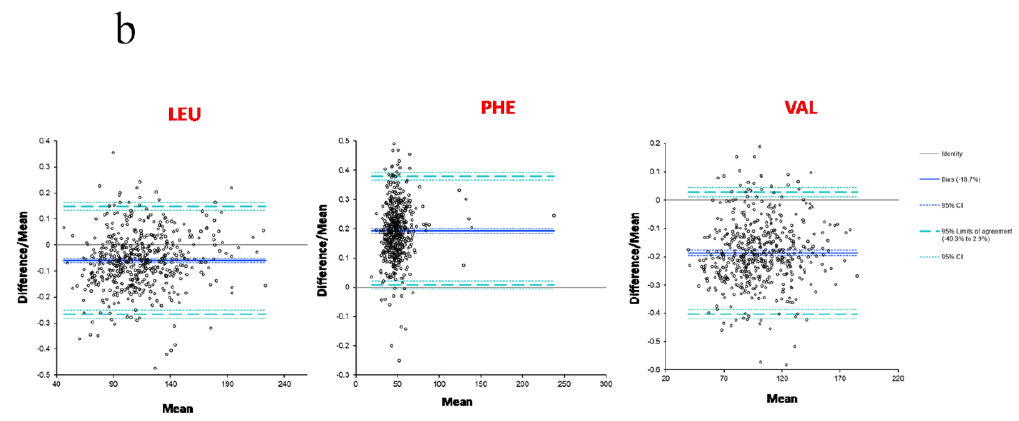
Figure 4. ( a ) Residual plots for Phe, Val, C3, and C18 after method comparison between NeoBase™ 2 and MassChrom ® non-derivatized kits; ( b ) difference plots for Leu, Phe, and Val after the removal of DBS samples from diagnosed IEMs subjects.